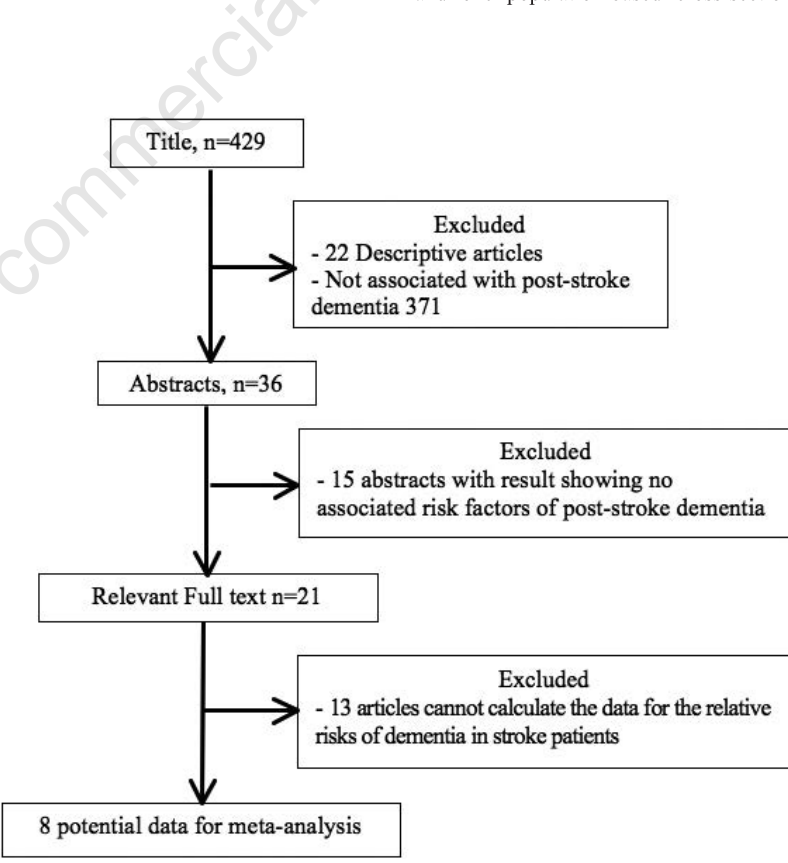
Figure 1. Literature search